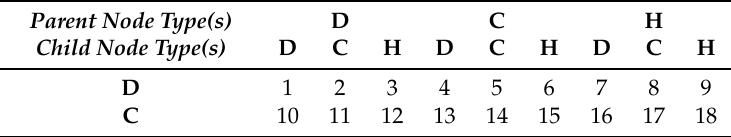
Table 1. Possible Node Types in a Hybrid Bayesian Network